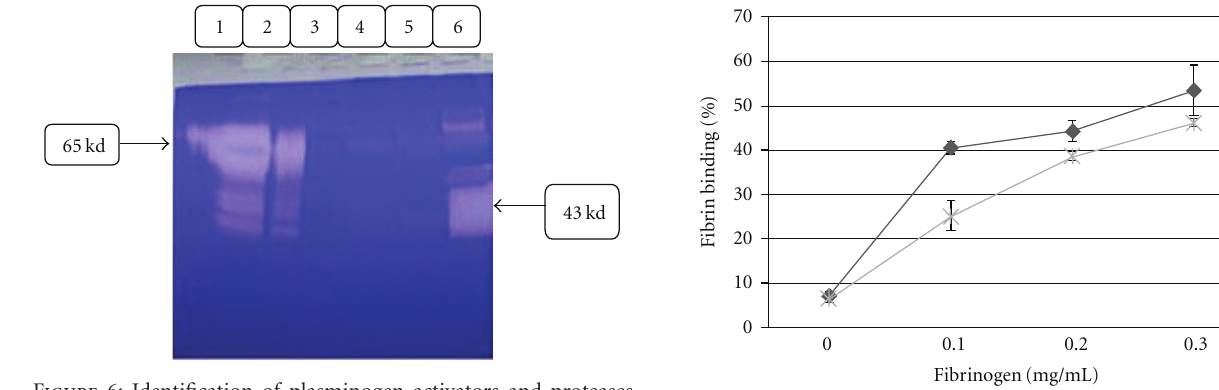
Figure 6: Identification of plasminogen activators and proteases in 11% polyacrylamide gel containing gelatin. The gel contains 11% polyacrylamide, 0.1% SDS, 0.1% copolymerized gelatin and